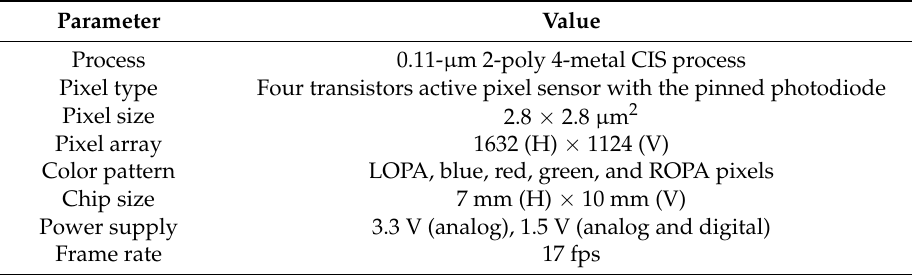
Figure 8. Camera board with the fabricated CIS using the OPA technique. Table 1. Summary of the fabricated CIS.